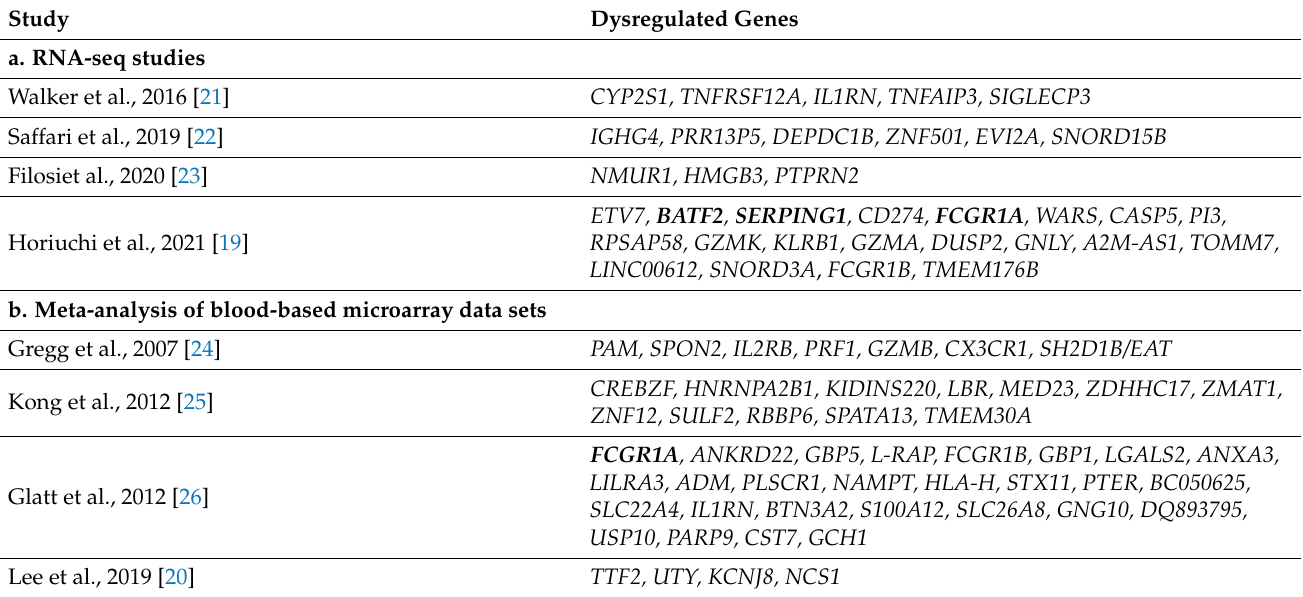
Table 3. Transcriptomic studies in whole blood samples from individuals with autism spectrum disorder (ASD) and NT controls. The NCBI PubMed database was searched (July 2022) as described under Methods. The abbreviations of dysregulated genes showing differential expression with P adj < 0.05 are presented. Studies are shown chronologically for each technology. (a) RNA-seq studies; (b) meta-analysis of blood-based microarray data sets. Genes found as dysregulated in ASD in our study (Table 2) are indicated by bold